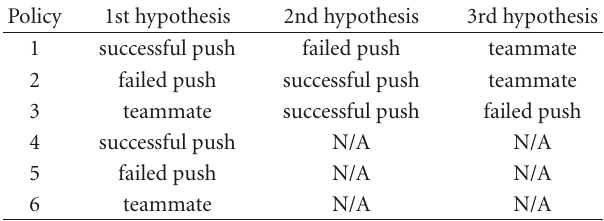
Table 1: Six multihypothesis tracking policies tested in